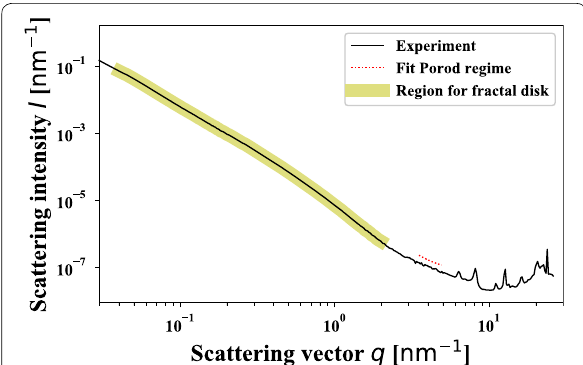
Fig. 8 Typical SAXS profile measured on white Portland cement, with indication of Porod regime and Fractal disk region (experimental data from Maruyama et al.